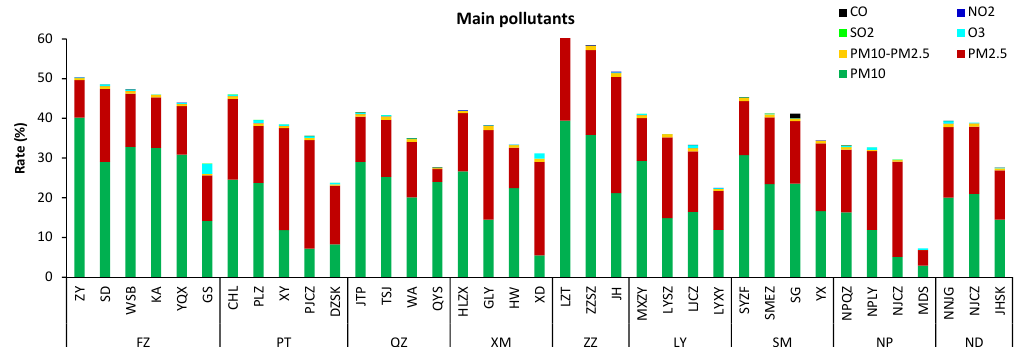
Figure 6. Total non-attainment rates and the major pollutants in the 37 stations of the 9 major cities in Fujian province (ranked by number of non-attainment days).